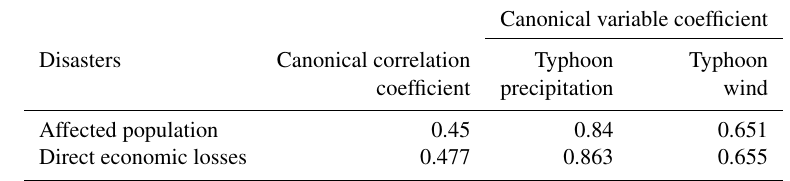
Table 1. Canonical correlation analysis of factors causing typhoon disasters.